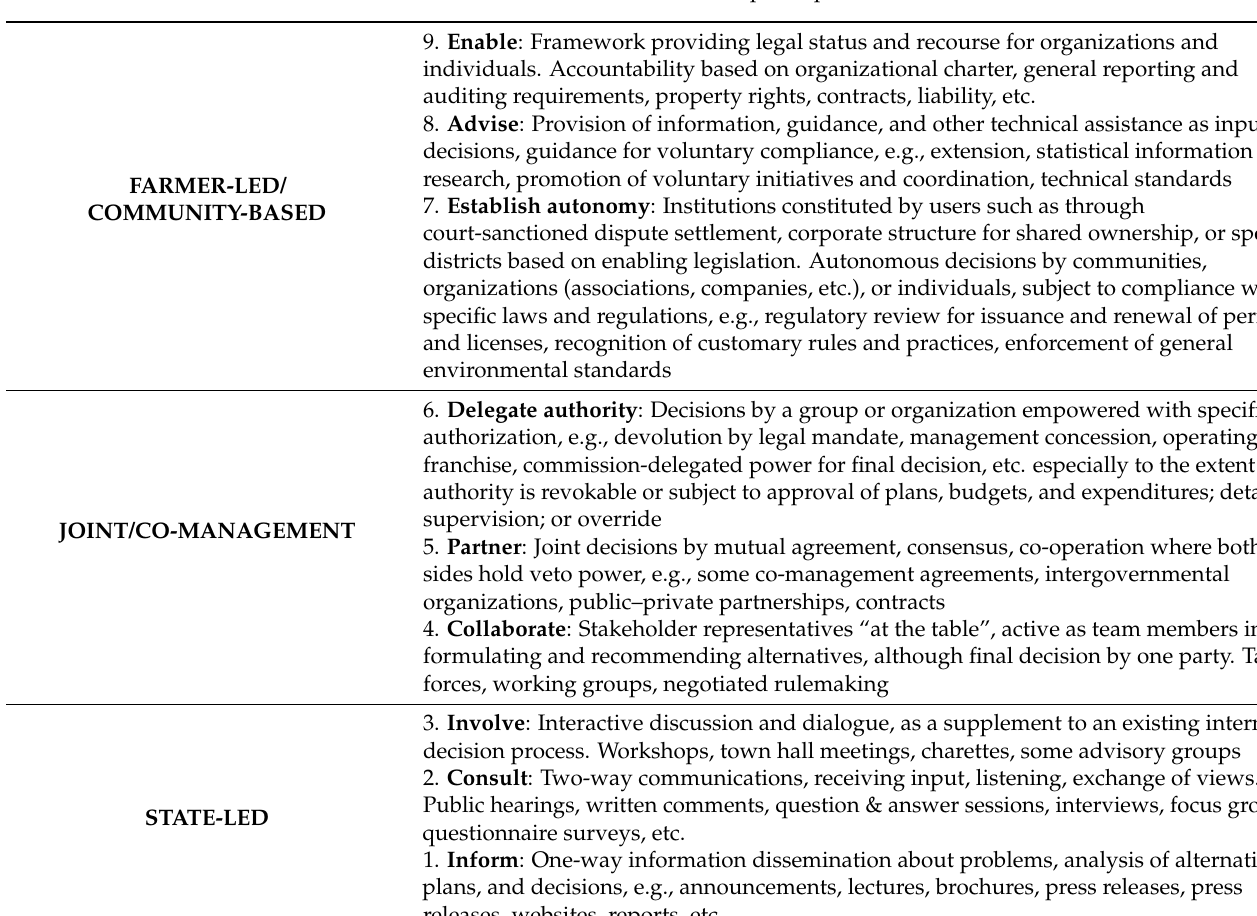
Table 1. An extended ladder of